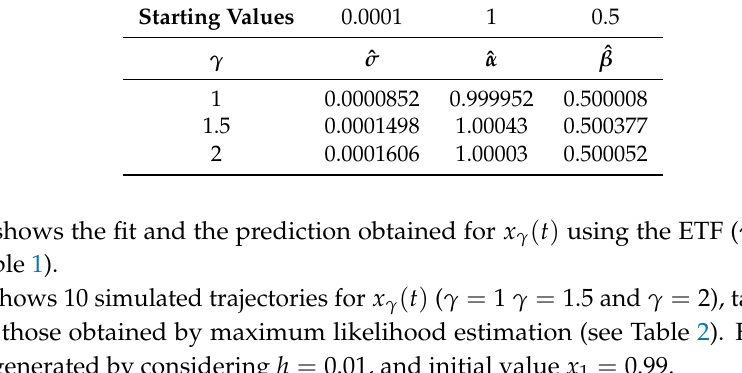
Table 2. Starting values used in the simulation and estimation of the parameters. σ α β Starting Values 0.0001